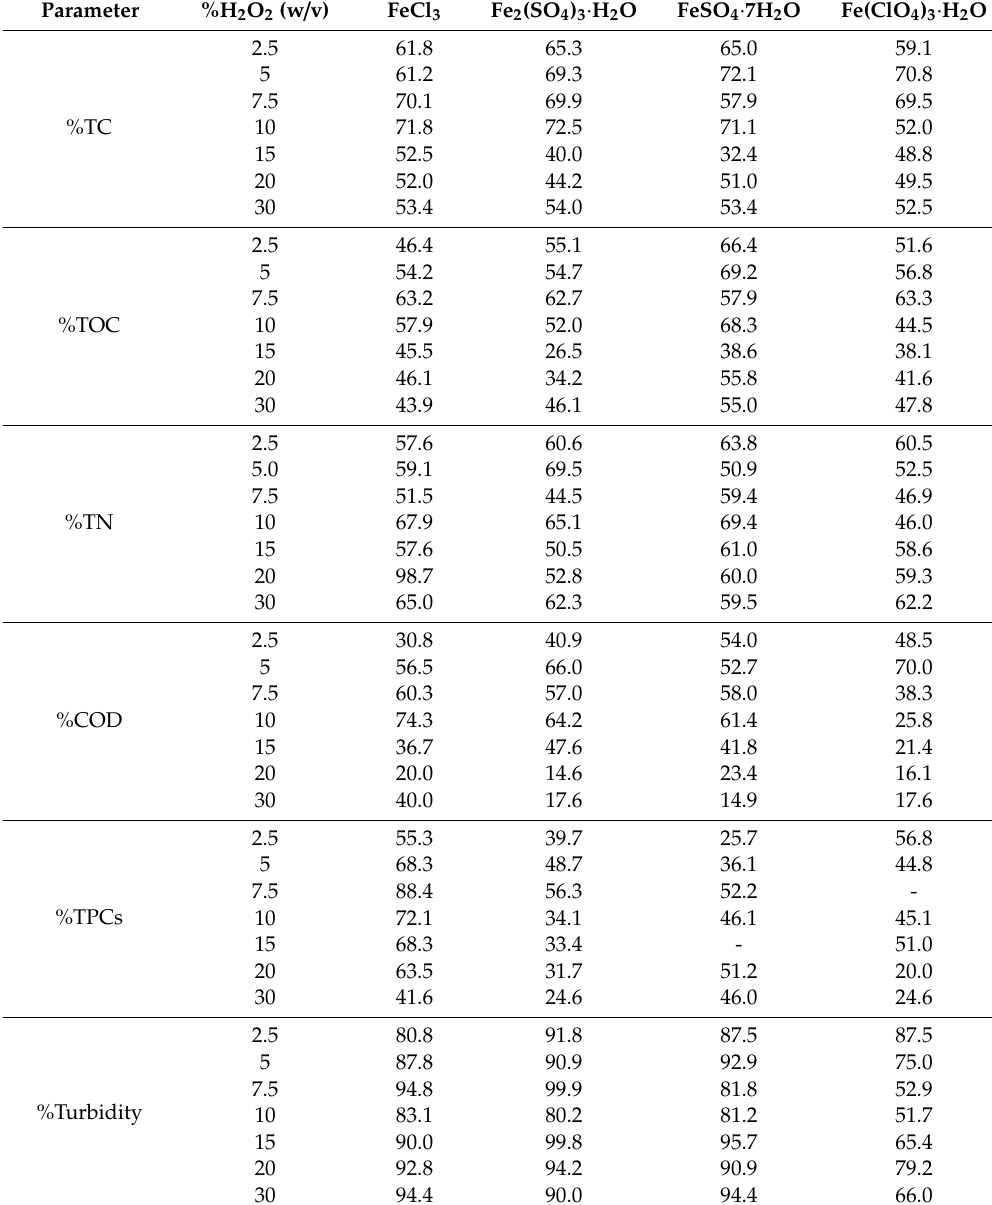
Table 3. Average TC, TOC, TN, COD, TPCs removal percentages determined after OMWs treatment by photo-Fenton at di ff erent oxidant concentrations. Operating conditions: pH = 3, T = 20 ◦ C, Agitation rate = 150 rpm, and [Catalyst] / [H 2 O 2 ] ratio =